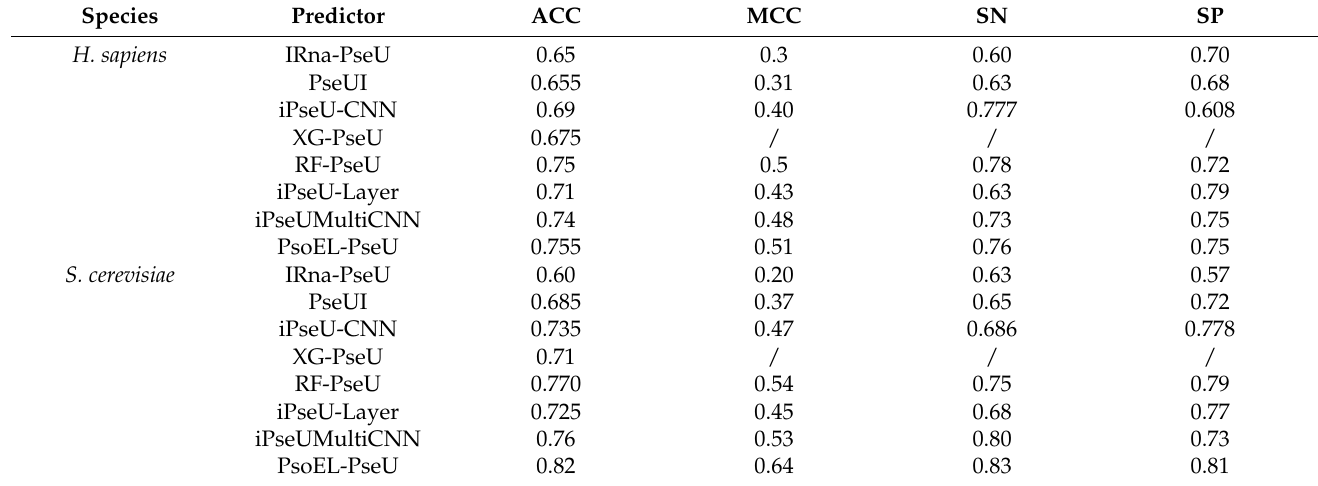
Table 2. Comparison of independent testing scores of PsoEL-PseU with existing state-of-the-art pseudouridine site